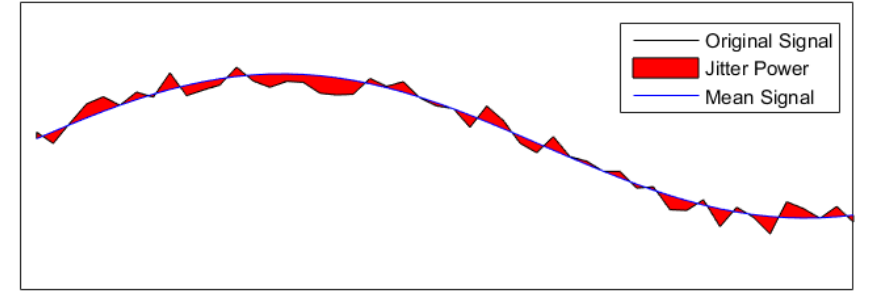
Figure 9. Jitter power